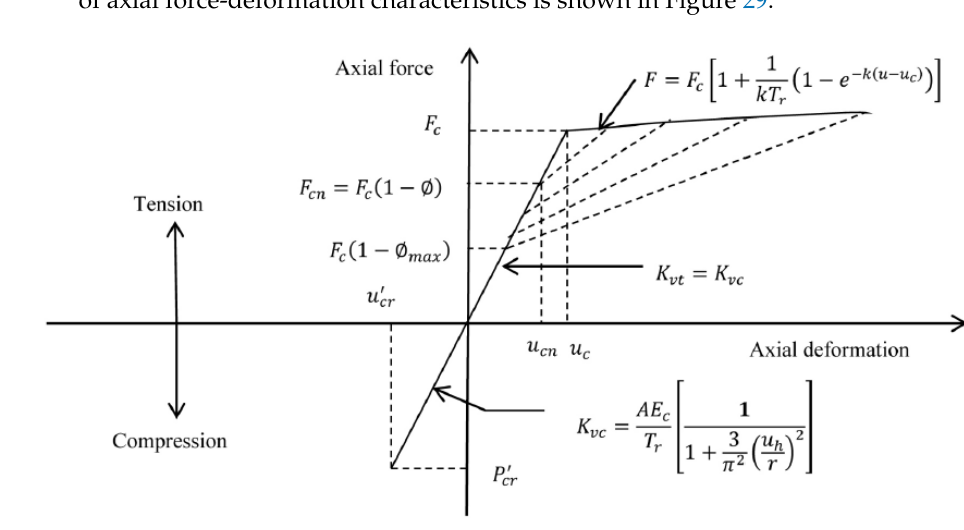
Figure 29. Variation of axial force and stiffness characteristics [116] .